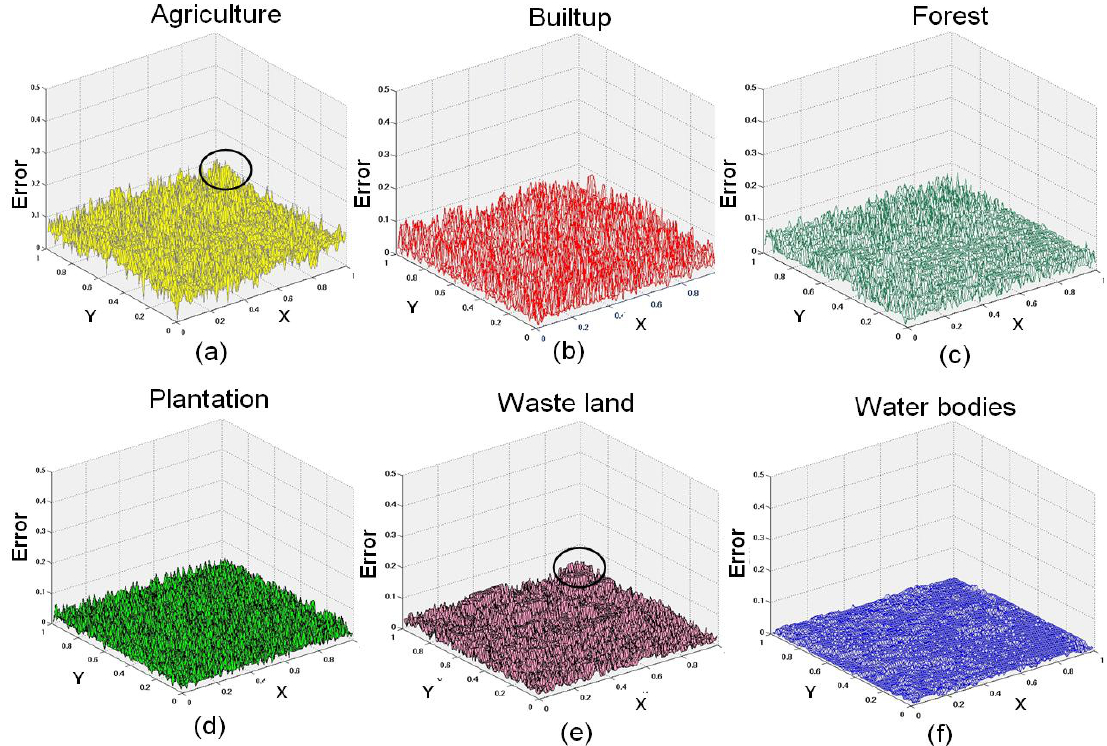
Figure 15. Error distribution of MODIS abundance obtained from HMM (X and Y axes are the two dimensions in feature space and Z axis is the absolute difference between real/reference and estimated class proportion) for the six classes.